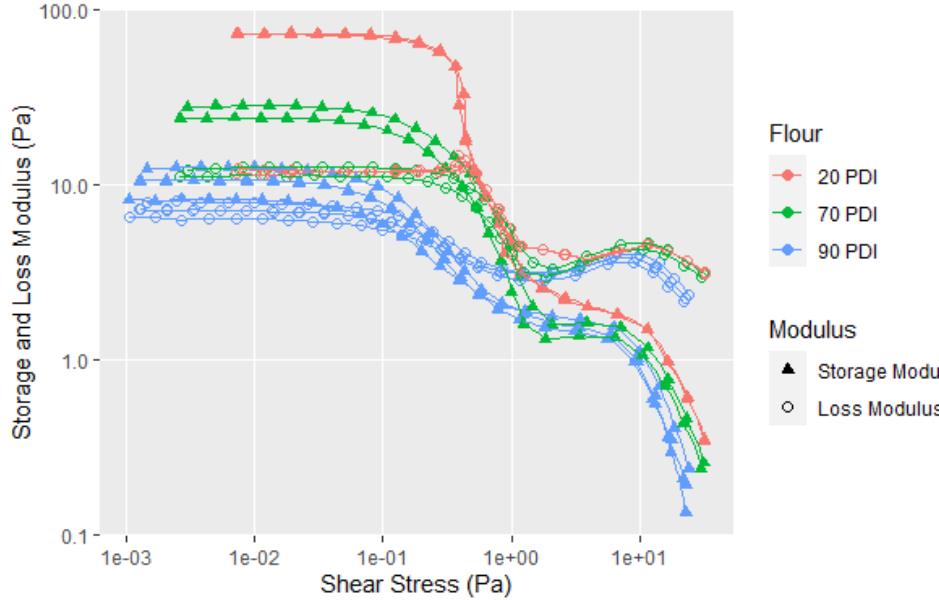
Figure A7. All replicates for samples shown in Figure 8.